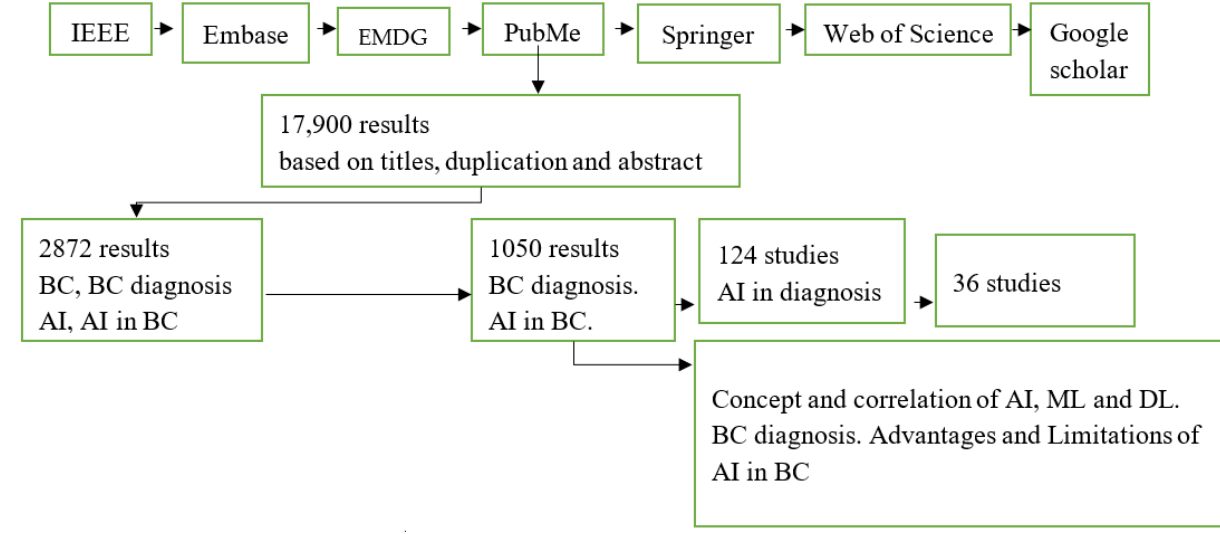
Figure 1. Block diagram of AI in BC diagnosis.